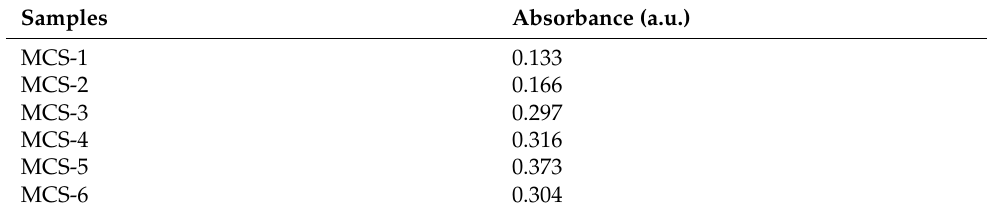
Figure 6. ( a ) UV-vis diffuse reflectance spectra of the MCS samples with a absorption edge located around 600 nm. ( b ) ( α h ʋ ) 0.5 versus h ʋ plots of the MCS samples.